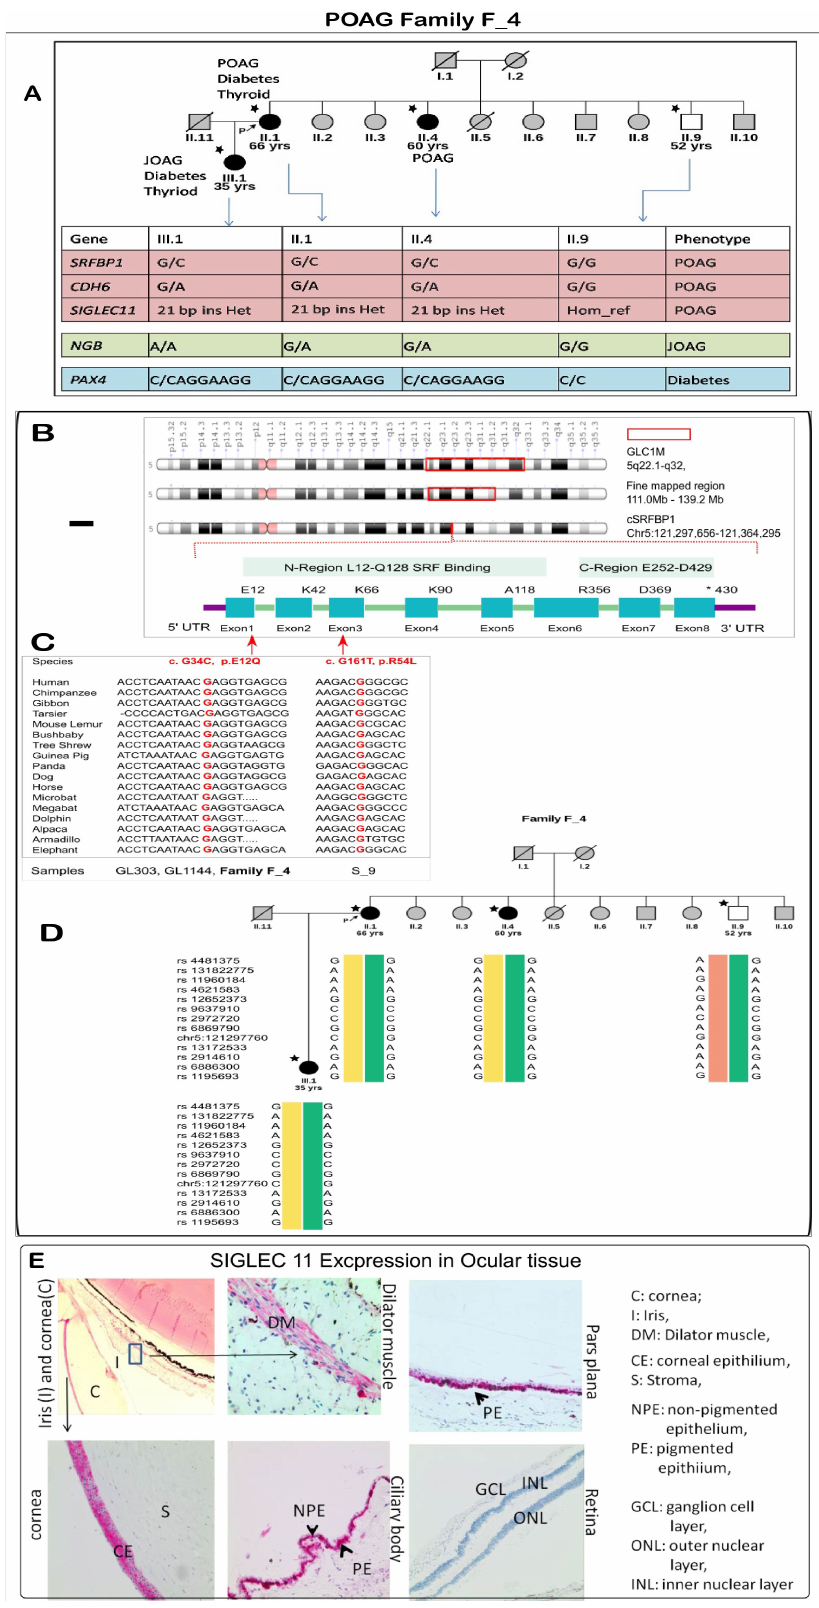
Figure 5. Detailed analysis of a POAG family . ( A ) Figure showing pedigree of the members of F_4 POAG family and the probable genotypes identified from our study that may be associated with